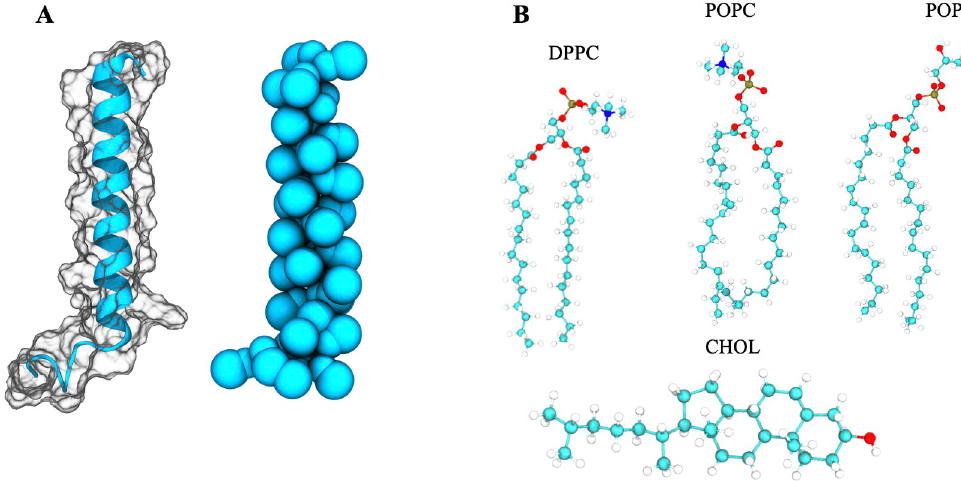
Fig 1. A) Atomistic (left) and coarse-grained (right) model of surfactant protein C (SP-C). B) Chemical structure of lipids used to mimic the pulmonary surfactant membrane: DPPC, POPC, POPG, and cholesterol (CHOL). See the text for details.